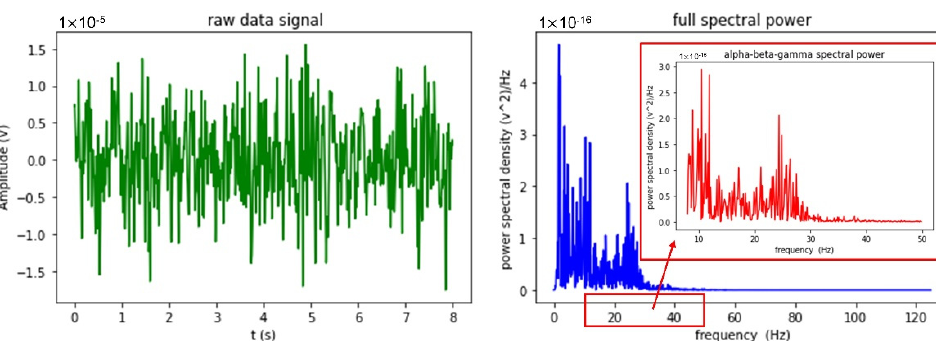
Figure 7. Time domain, full frequency domain, and filtered alpha-beta-gamma frequency EEG waveforms of an individual. Table 1. Results of three types of input